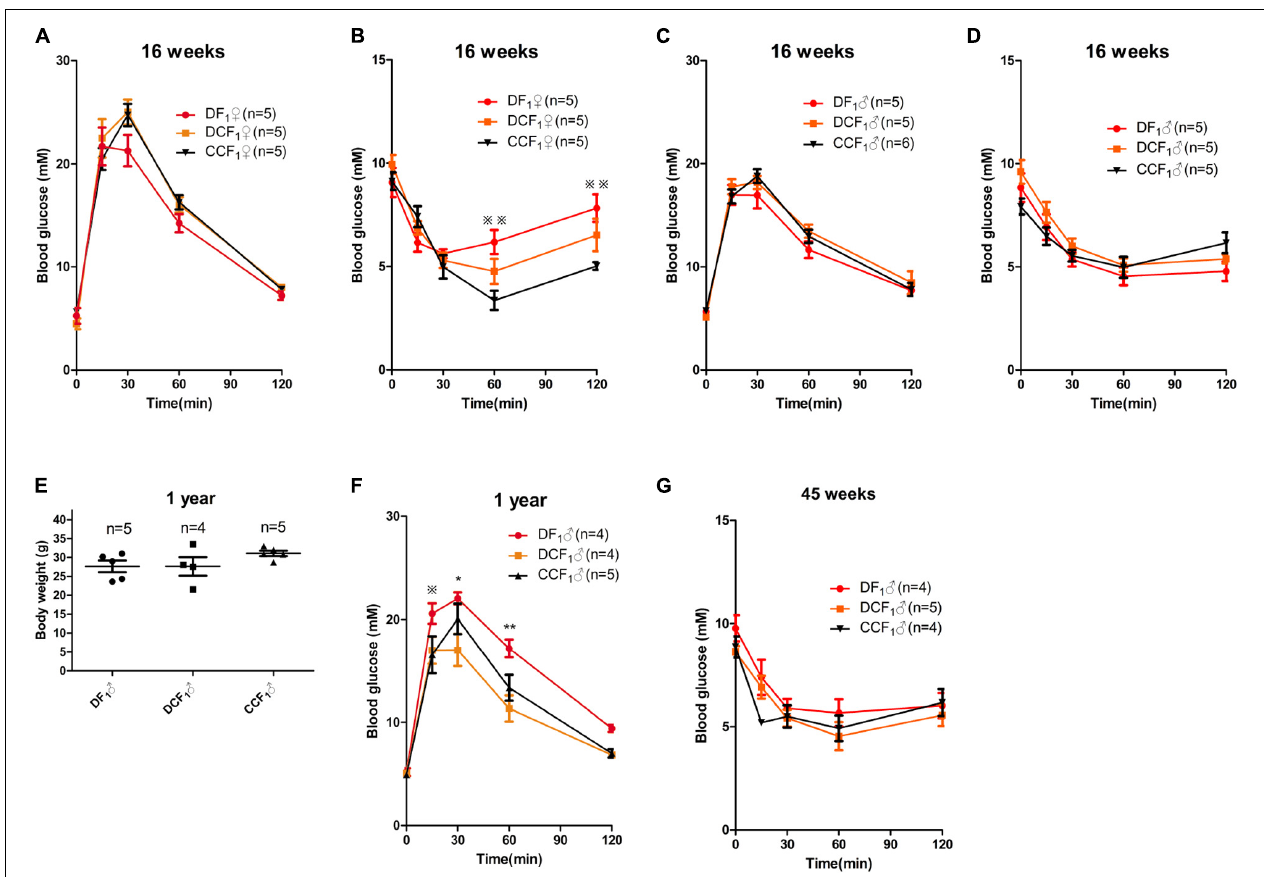
FIGURE 5 | F 1 metabolic phenotype. (A,C) Blood glucose concentrations during GTT in female (A) and male (C) F 1 mice at 0, 15, 30, 60, and 120 min after intraperitoneal glucose injection when they were 16 weeks of age. (B,D) Blood glucose concentrations during ITT in female (B) and male (D) F 1 mice at 0, 15, 30, 60, and 120 min after intraperitoneal insulin injection when they were 16 weeks of age. (E) Scatter plots of the body weight distribution for male F 1 at 1 year of age. (F) Blood glucose concentrations during GTT in male F 1 mice at 0, 15, 30, 60, and 120 min after intraperitoneal glucose injection when they were 1 year of age. (G) Blood glucose concentrations during ITT in male F 1 mice at 0, 15, 30, 60, and 120 min after intraperitoneal insulin injection when they were 45 weeks of age. Data are expressed as mean ± S.E.M.; * P < 0.05, ** P < 0.01 DF 1 vs. DCF 1 . Statistical significance, DF 1 vs. CCF 1 , is represented using . There is no statistical significance between DCF 1 and CCF1. A two-way repeated measurement ANOVA in (A–D,F) and a one way ANOVA in (E) , post hoc Bonferroni multiple- comparisons test was used to assign P -values by comparing to each other. P -values for significance between groups in repeated measure analysis are